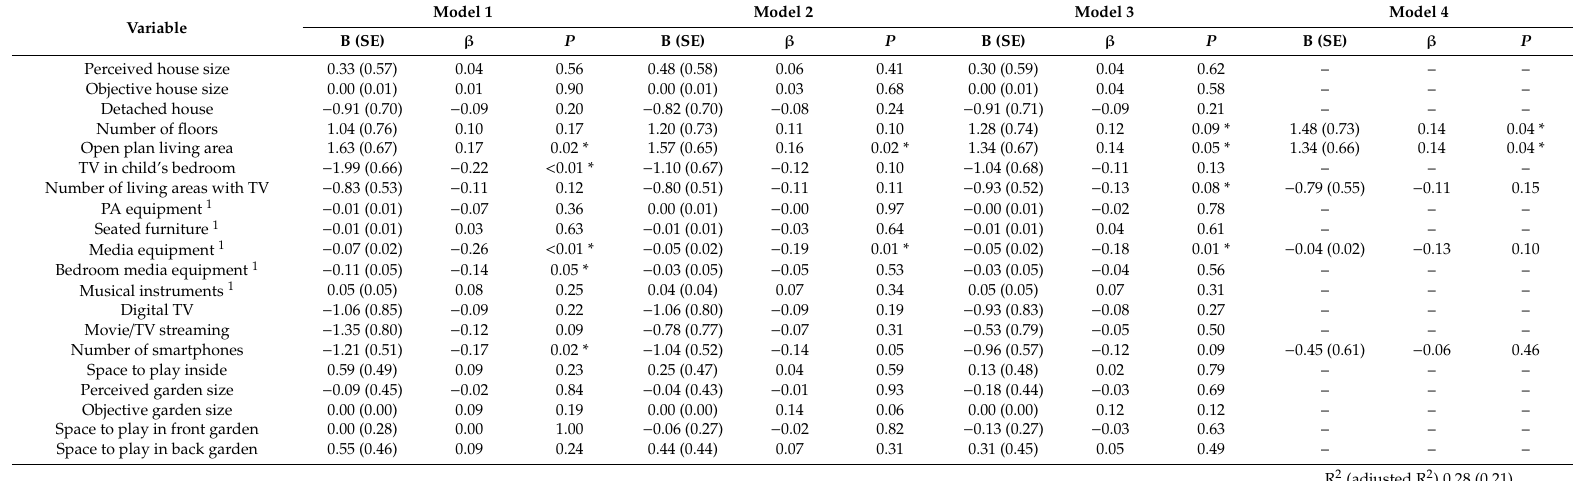
Table 5. Associations between physical home factors and children’s home-based